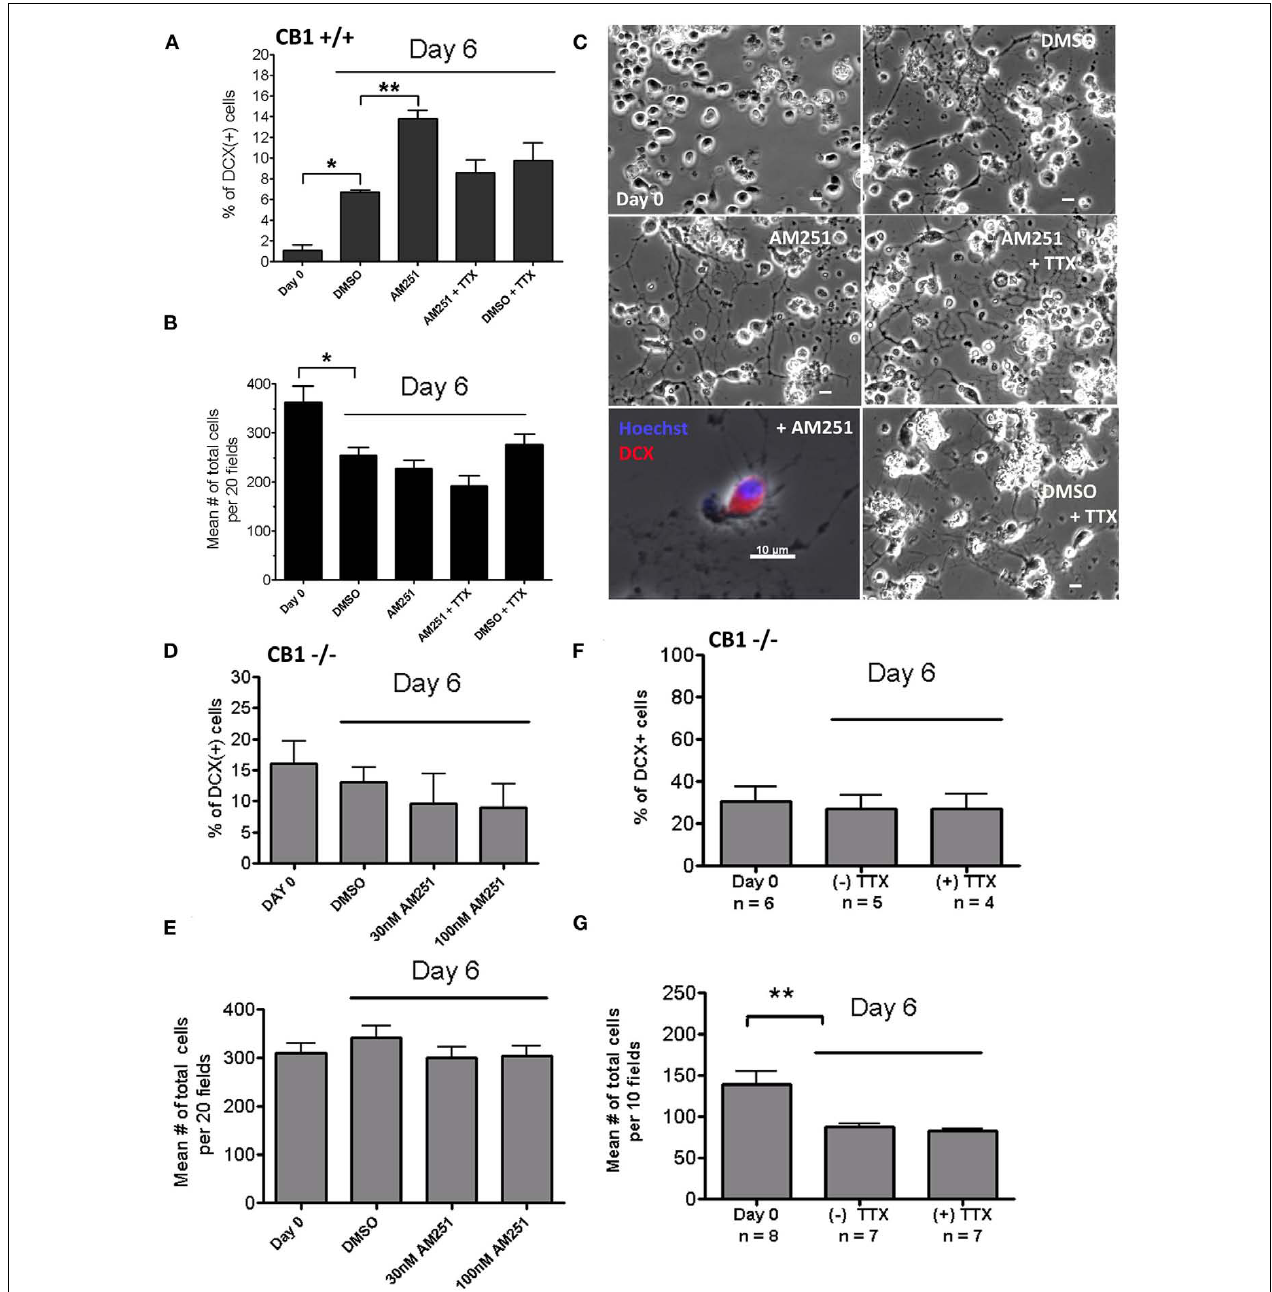
cultures. 10 × Objective; Scale bars = 10 μ m. Bottom left panels shows a DCX( + ) cell at a higher magnification (40 × objective). (D,E) AM251 does not significantly change the percentage of DCX( + ) cells (D) neither the total number of cells (E) in CB1 − / − spinal cord cultures.Twenty random fields were analyzed per coverslip; n = 3 coverslips; mean + SEM. (F,G) A total of 10 fields per each coverslip ( n ) were analyzed. (F) The percentage of DCX( + ) cells remains unchanged in the presence of the Na + channel blockerTTX(1 μ M). (G) The total number of cells was not significantly different among treatments. Data generated from three CB1 − / − mice. In this experiment there was a significant decrease in the total number of cells between Day 0 to Day 6 (** p < 0.01; but see Figure 5C and text). For (A–G) we used One-way ANOVA, Bonferroni post